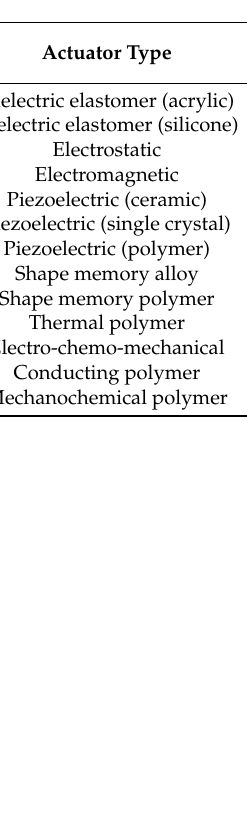
Figure 9. Working principle of DEA. 3.